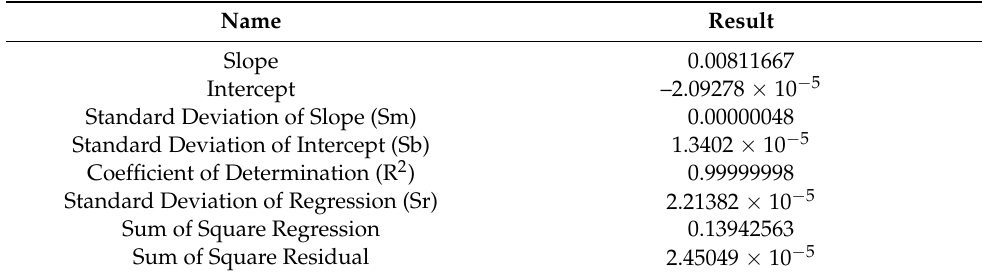
Table 4. The linearity and the uncertainty of the calibration curve threshold (Figure 3).